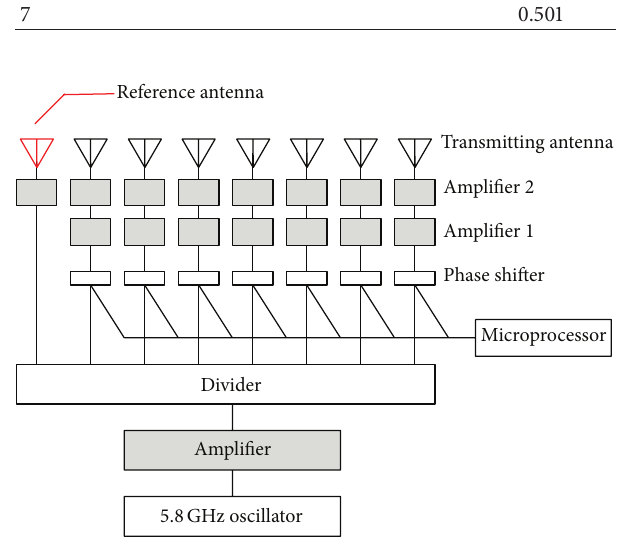
Figure 4: Block diagram of power transfer system.